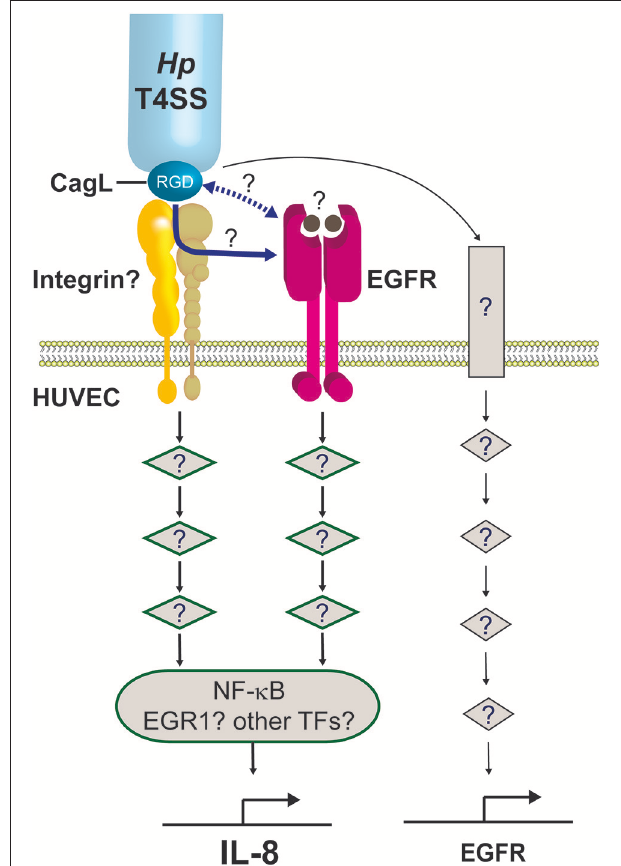
FIGURE 8 | Working model on the molecular mechanism by which the H. pylori T4SS induces potent IL-8 induction in human endothelial cells. We propose that the H. pylori T4SS triggers IL-8 induction in endothelial cells by interacting with an as yet unidentified integrin (shown as yellow/beige heterodimer) via the T4SS-associated adhesin, CagL, and its RGD motif. This triggers the activation of downstream signaling intermediates (diamond symbols), leading to activation of NF- κ B and subsequent expression of IL-8. Other transcription factors (TFs) important for regulating inflammatory genes, such as EGR1, AP-1, or STAT3, may also contribute to the induction of IL-8 in endothelial cells. This study shows that the H. pylori T4SS/CagL is capable of upregulating EGR1 expression (not depicted). The latter is a known downstream response of EGFR activation. The precise mechanism by which the H. pylori T4SS/CagL triggers activation of EGFR signaling is currently unclear. It may occur either via integrin-EGFR crosstalk subsequent to the binding of CagL to integrin (blue solid arrow) or direct interaction of CagL with EGFR via an unknown mechanism (blue dashed arrow). Alternatively, CagL-integrin interaction may activate an ADAM17-like metalloprotease that results in the shedding of heparin-binding epidermal growth factor (HB-EGF) (solid circles), which then binds to EGFR and activates EGFR signaling. Finally, our findings show that H. pylori T4SS/CagL is able to upregulate EGFR expression. We propose that this occurs via stimulation of a hitherto unknown receptor (rectangle) and the corresponding downstream signaling pathway, acting as a positive feedback mechanism by which H. pylori further potentiates EGFR-dependent IL-8 induction in HUVECs. The number of signaling intermediates illustrated is